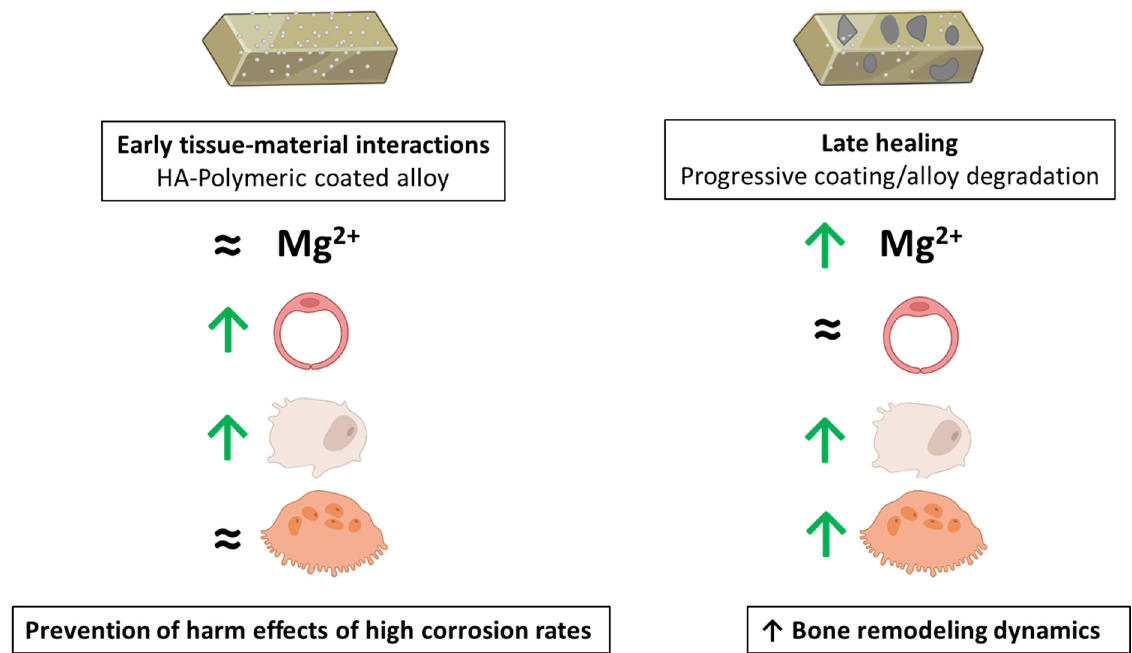
Figure 7. The main effects of the multifunctional Mg-based alloy on HUVECs, hBMCs, and osteoclasts. ≈ - No differences in comparison to the control cultures (absence of the extracts).